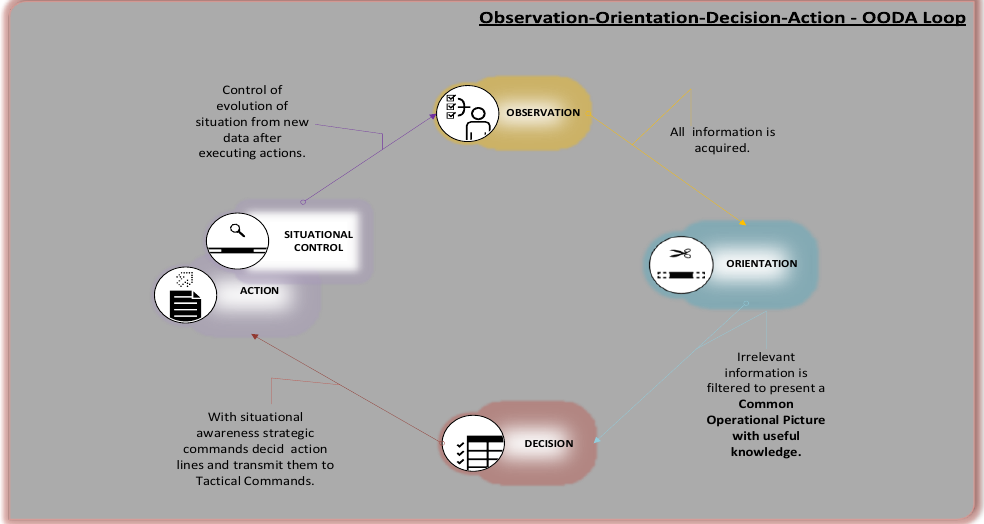
Figure 2. Command and Control OODA Loop.